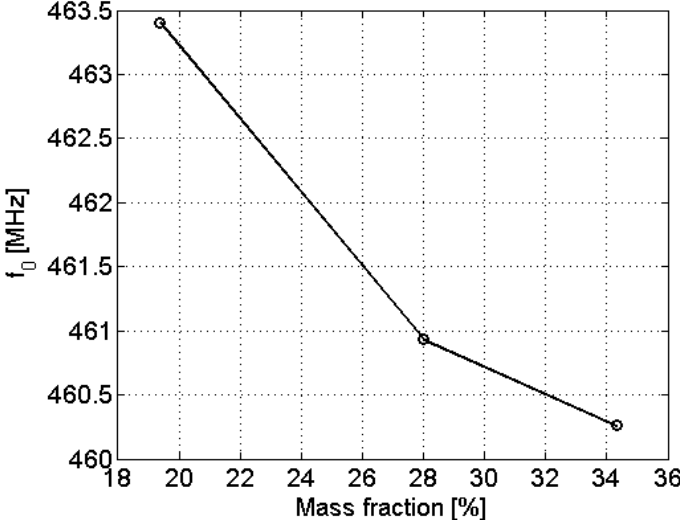
Figure 8. Evolution of the resonant frequency f 0 with the mass fraction of aromatic hydrocarbons.